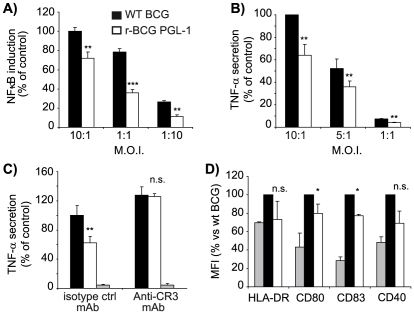
PGL-1 production impairs the initiation of innate immune responses.(A) Activation of the NF-κB pathway, as evaluated by the THP-1 Blue cell line and assay of SEAP activity, following infection with WT BCG (black bars) or r-BCG PGL-1 (white bars) at various MOI. The mean OD630nm values for WT BCG were 1.13, 0.905, and 0.246 at MOI 10∶1, 1∶1 and 1∶10 respectively whereas the value obtained for r-BCG PGL-1 were 0.87, 0.368 and 0.073 at the same MOI. The value used to normalize at 100% was 1.13 units. (B) TNF-α production by hMDM after 2 hours of post-infection. One hundred percent corresponded to 10538±1579 pg/ml. (C) TNF-α production by hMDM pre-incubated with mAbs directed against CR3 or with irrelevant isotype control and infected during 2 hours at a MOI of 10∶1. One hundred percent corresponded to 4101±551 pg/ml. (D) Expression of maturation markers at the surface of infected hDC, as analyzed by flow cytometry. Data are presented as the percentage of SEAP activity, TNF-α production or MFI with respect to the WT BCG (100%). The values are means ± SEM of 2 (panels A and C) and 4 independent experiments (panels B and D). In panels C and D, grey bars corresponded to uninfected controls. Differences between BCG control and r-BCG PGL-1 were statistically evaluated: *, p<0.05 ;**, p<0.01; ***, p<0.001; n.s., not significant.